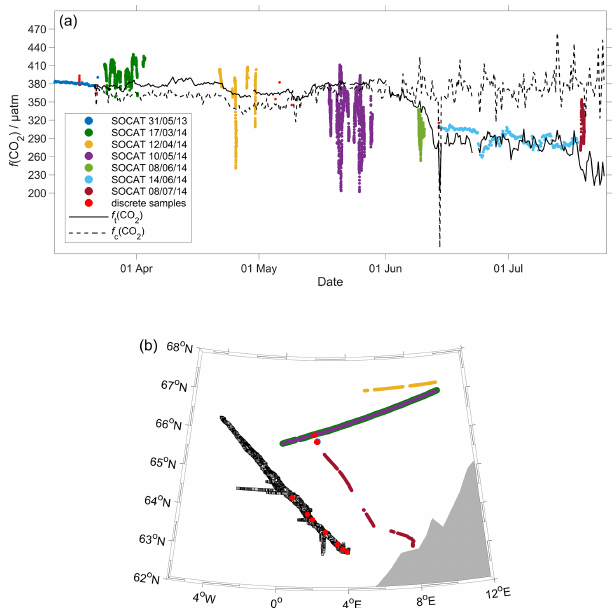
Figure 11. Comparison between surface f (CO 2 ) from 2014 SO- CAT and CO 2 optode on the glider. (a) The black lines are the median glider f (CO 2 ) in the top 10m, with f c (CO 2 ) (dotted line) corresponding to regression 1 (Fig. 6a) and f t (CO 2 ) (continuous line) to regression 2 (Fig. 6a). Discrete samples collected during the deployment are shown as red dots, with the other coloured dots representing cruises in the SOCAT database (Bakker et al., 2016). (b) Glider and SOCAT data positions (same colours as in panel a ).